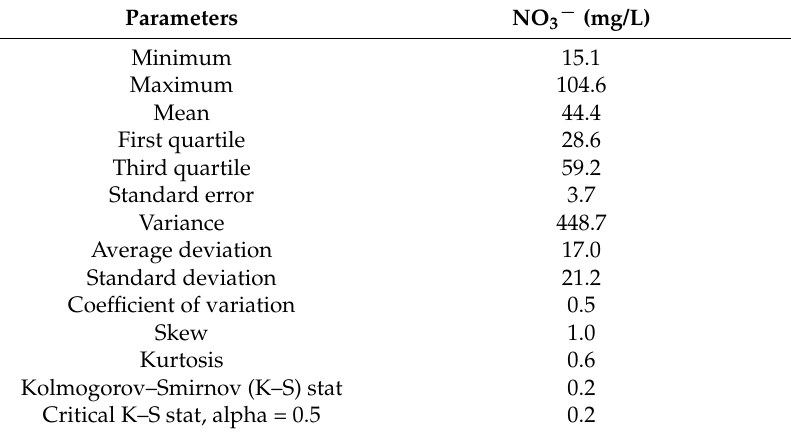
Table 10. Summary statistics of nitrate data.